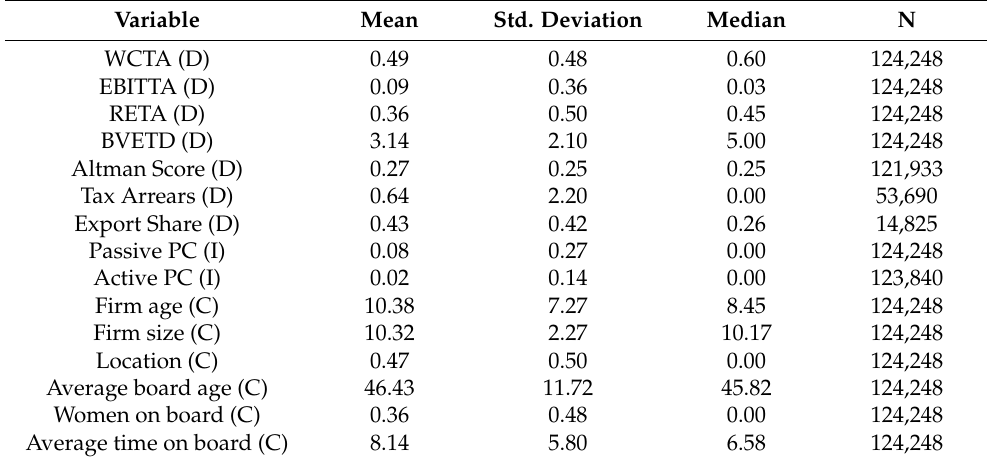
Table 1. Descriptive statistics of dependent (D), independent (I), and control (C) variables.